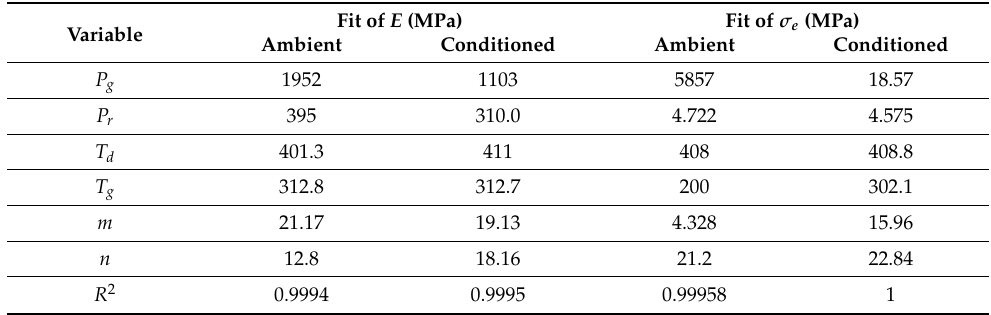
Table 2. Variables of the mathematical model to fit the linear elastic values in a temperature range of 23–100 ◦ C or 296–373